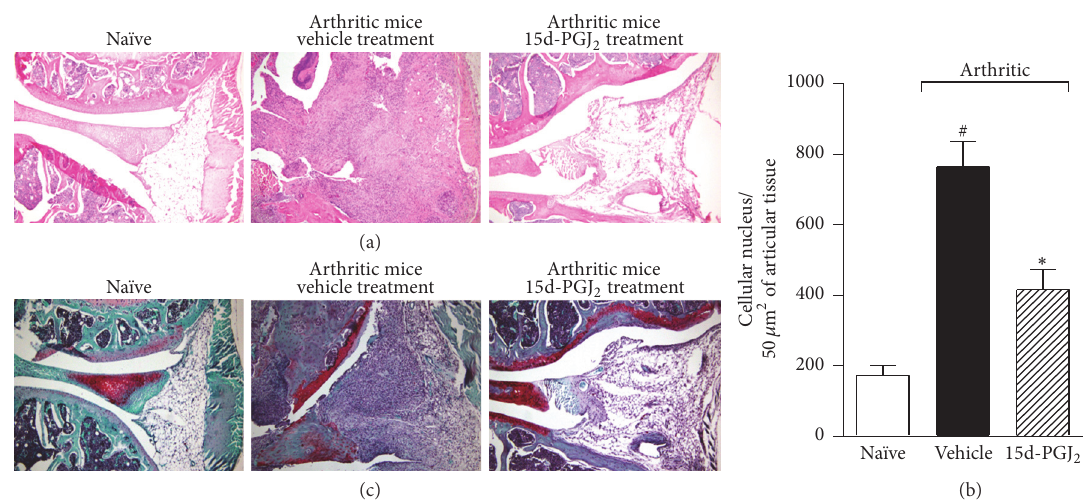
Figure 2: 15d-PGJ 2 treatment ameliorates articular inflammation. Na¨ıve or collagen-immunized and challenged DBA/1 mice were injected s.c. daily with vehicle or 15d-PGJ 2 (1mg/Kg) for 7 days. At the end of treatment, mice were euthanized, the articular joints were harvested,